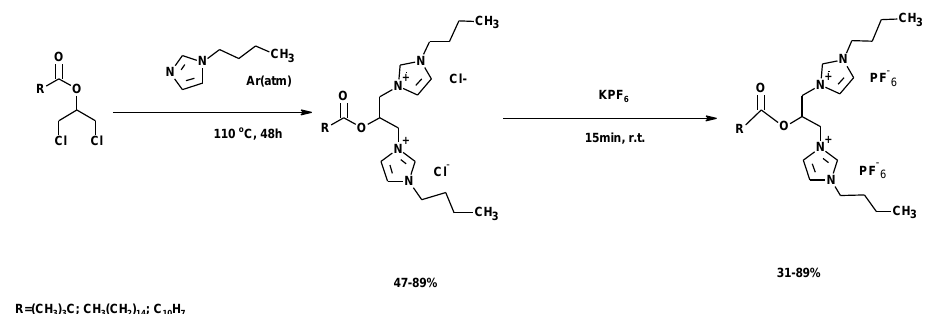
Figure 31. Synthesis of ionic compounds from chlorohydrin esters.